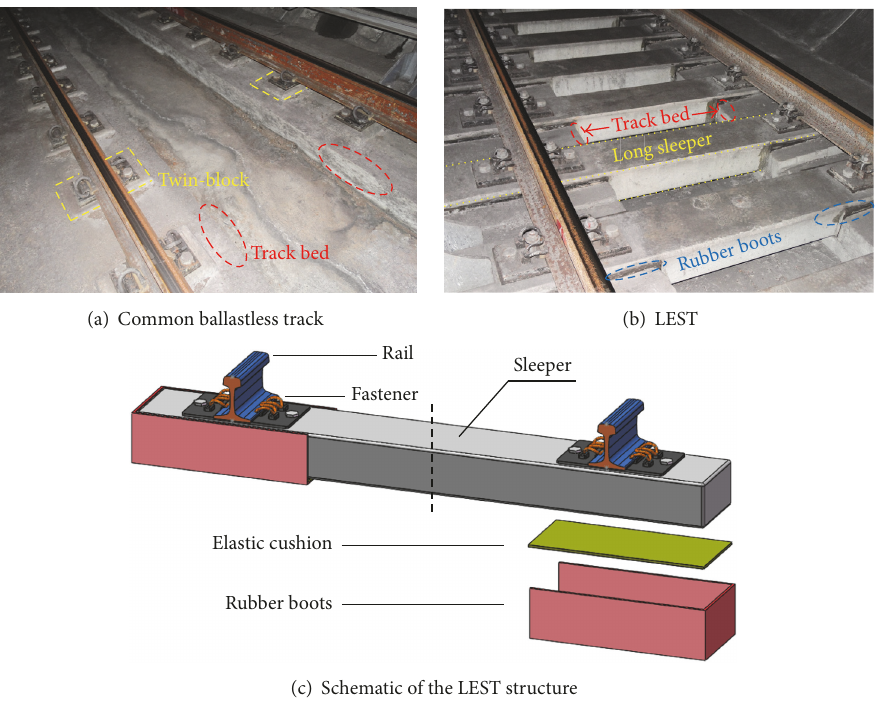
Figure 1: Track structures of dynamic